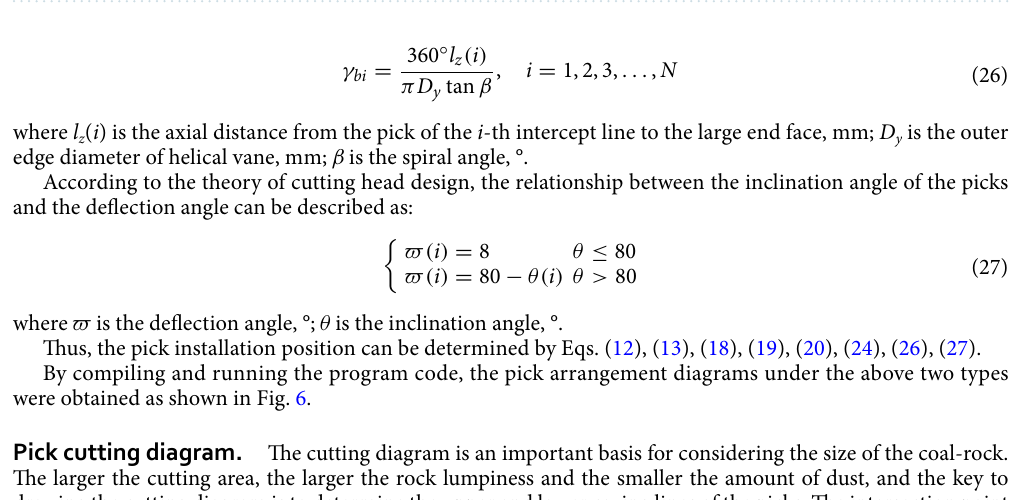
Figure 5. The design sketch of the spherical